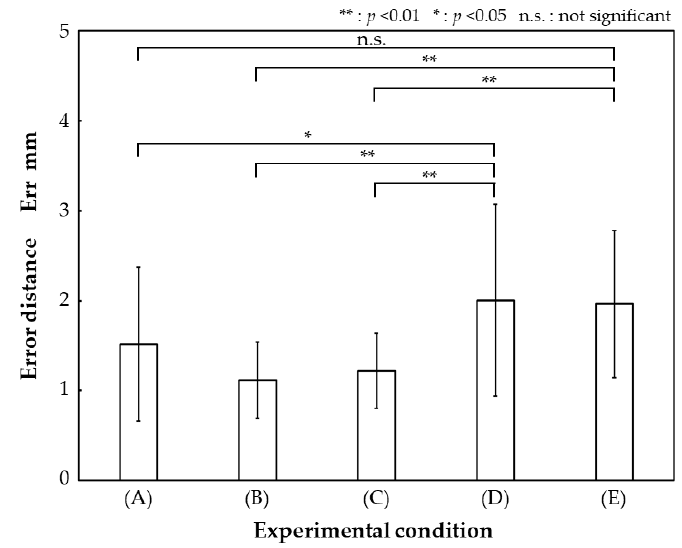
Figure 6. Accuracy of needle-hooking task.